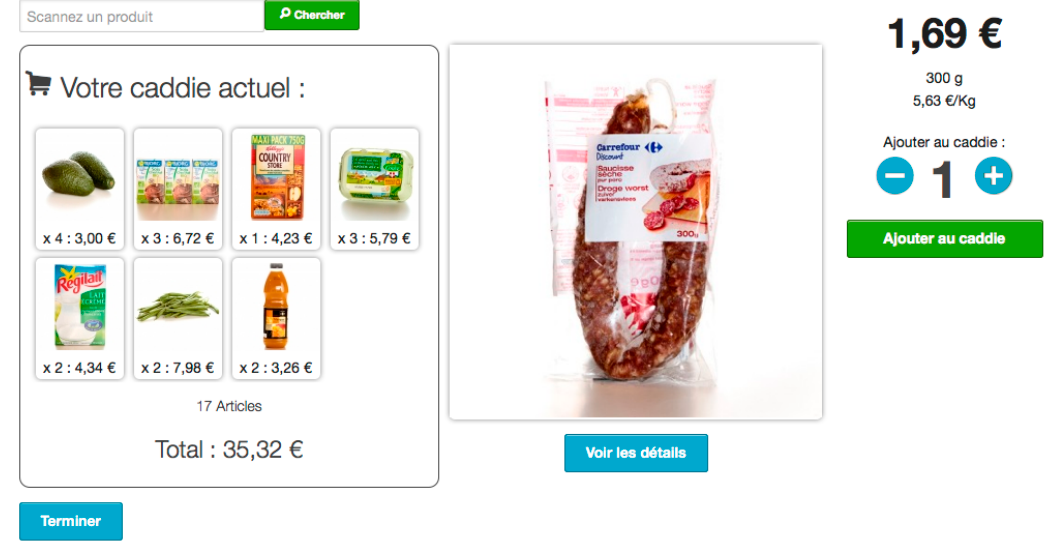
Figure A17. Screenshot.